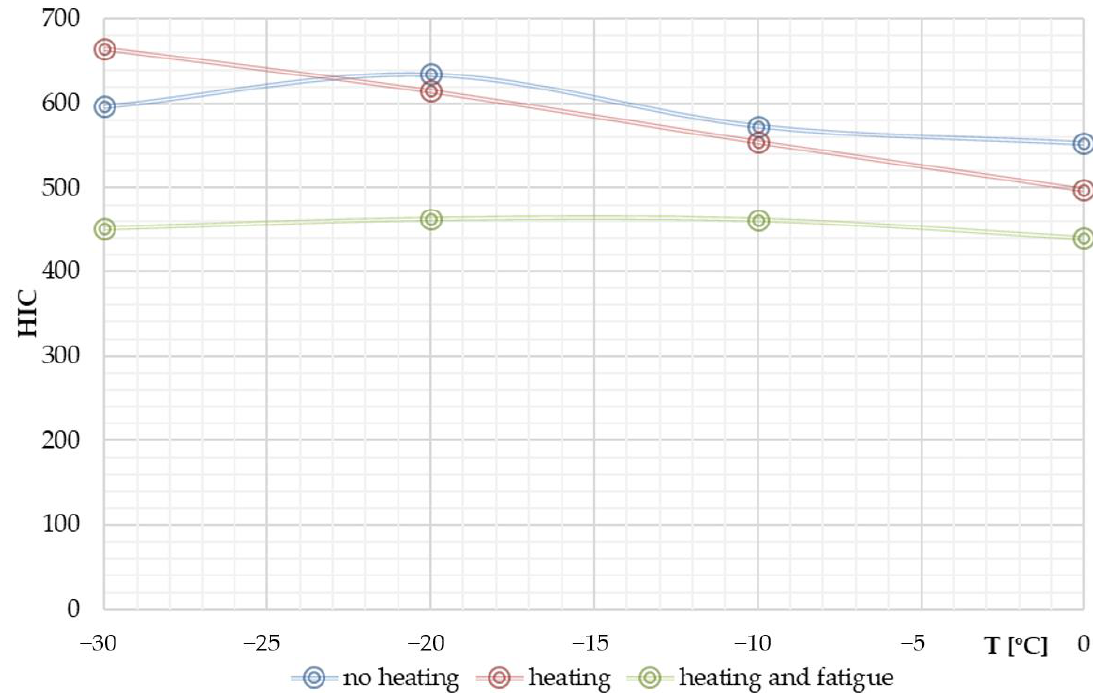
Figure 17. HIC for non-heated windscreen, heated windscreen, and heated windscreen + fatigue.